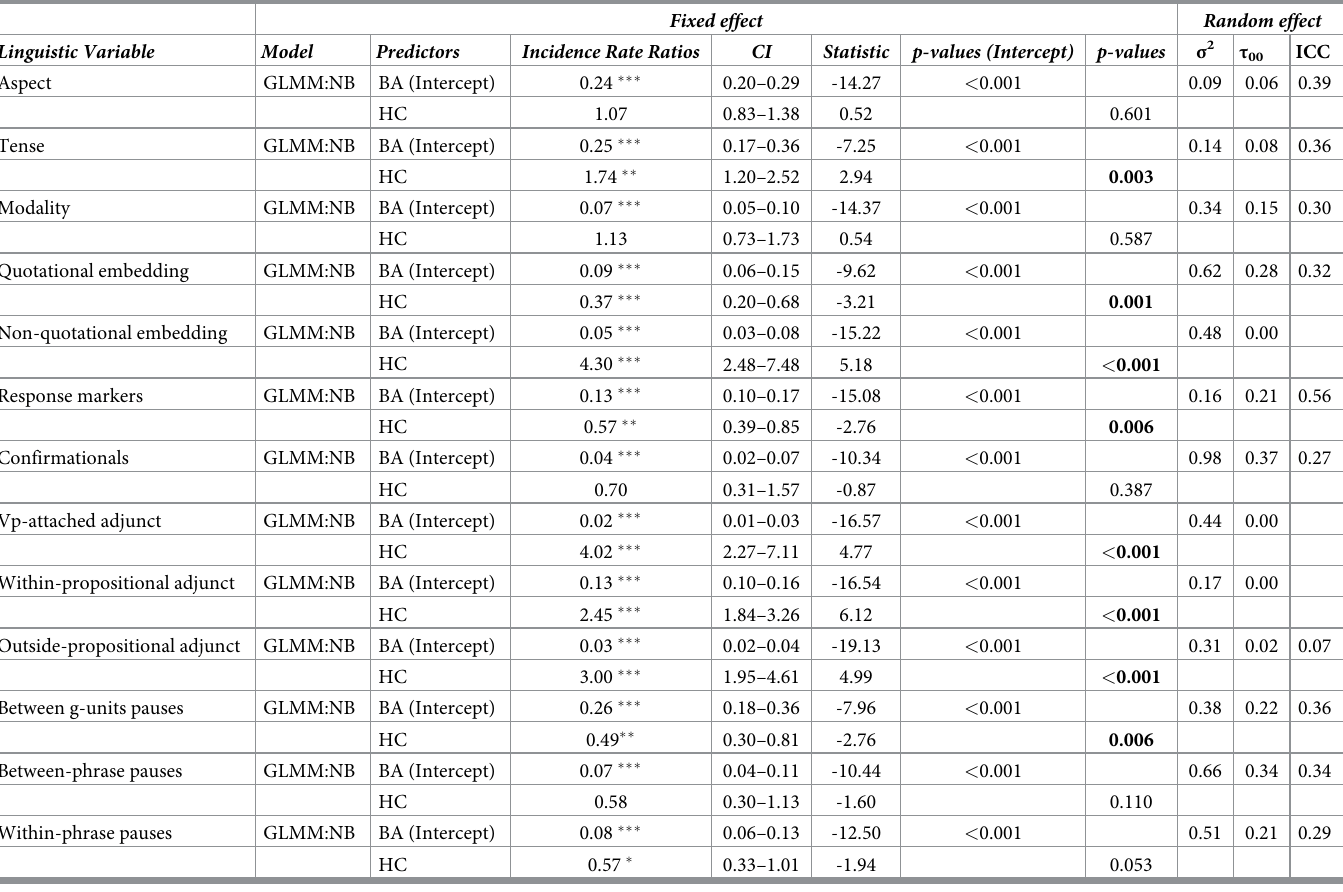
Table 2. Statistical significance for possible group differences in the 13 linguistic